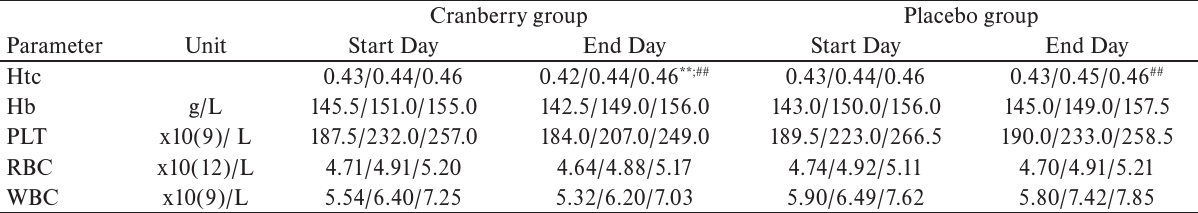
Table 3. Markers of